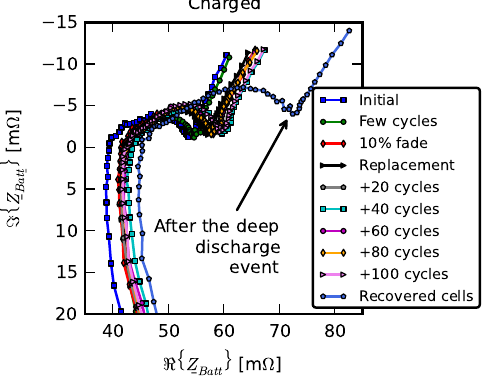
Figure 13. Average impedance spectra of a pack comprised of eight aged cells and one new (Scenario 1).